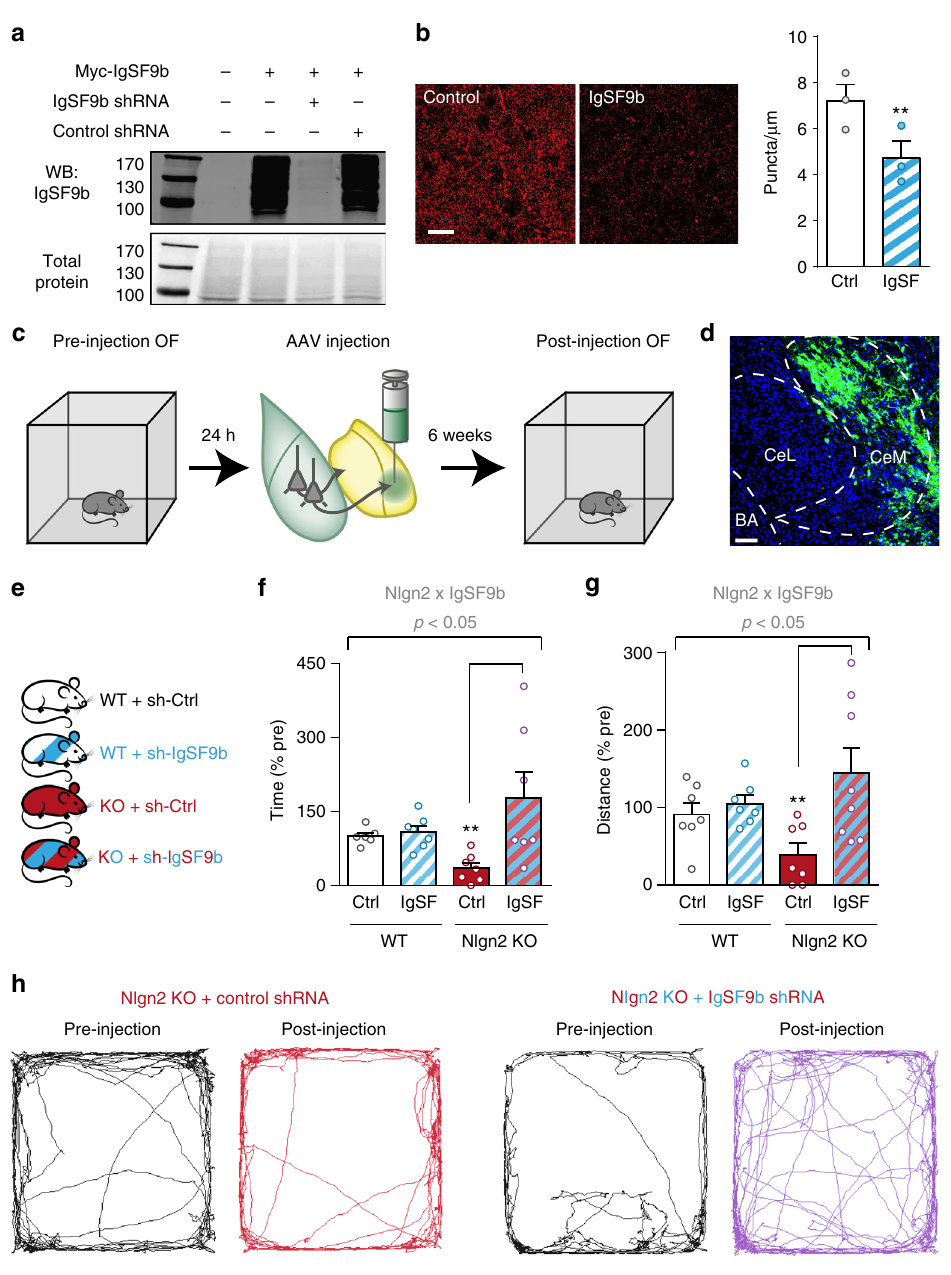
Fig. 4 Local knockdown of IgSF9b in the adult CeM ameliorates anxiety-related behaviors in Nlgn2 KO mice. a Immunoblot for IgSF9b in HEK cell lysates transfected with a Myc-IgSF9b construct and IgSF9b shRNA or control shRNA 14 . Numbers next to the protein ladder represent molecular weight in kDa. b Representative images and quanti fi cation of perisomatic IgSF9b puncta in the CeM following injection of control shRNA or IgSF9b shRNA. n = 3 mice. Scale bar, 20 μ m. c Schematic diagram showing experimental design of IgSF9b shRNA experiment. Mice were tested in the OF 24 h before (pre) and 6 weeks after (post) injection. d Representative image of GFP-positive neurons in viral injection site. e Four experimental groups were generated: WT + control shRNA (white), WT + IgSF9b shRNA (white and blue striped), Nlgn2 KO + control shRNA (red), and Nlgn2 KO + IgSF9b shRNA (red and blue striped). f Time in center post-injection expressed as % pre-injection. g Normalized distance in center post-injection expressed as % pre-injection. h Representative tracks of OF exploration of Nlgn2 KO mice pre- and post-injection. Statistically signi fi cant ANOVA comparisons are marked in gray at the top of the panels and are listed in Table 1. For all other ANOVA comparisons F < 1. Post-hoc analysis: * p < 0.05 relative to WT, ** p < 0.01 relative to WT. Error bars represent SEM, n = 6 – 9 mice per